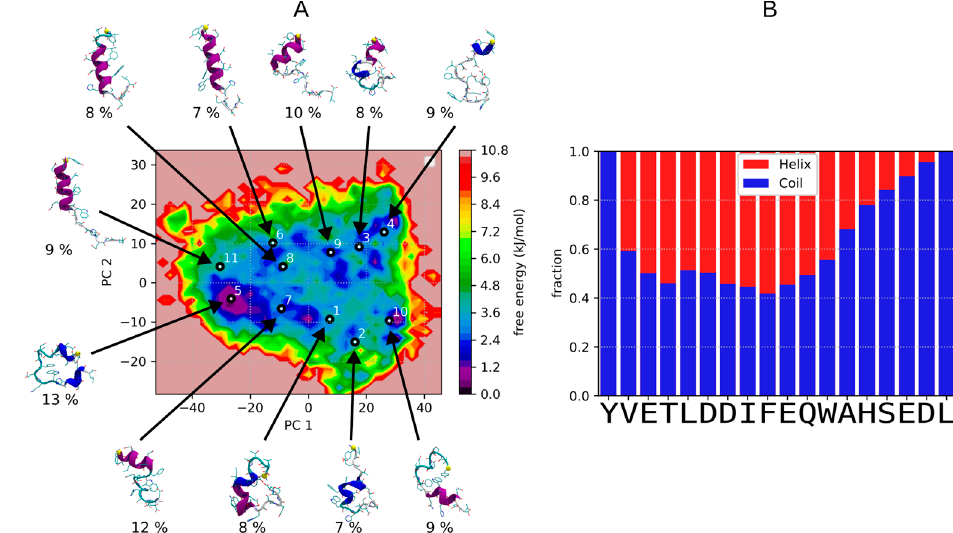
Figure 1. Structural landscape explored during ST simulations of C9h in aqueous solvent: ( A ) Free energy landscape at 300 K frames projected on principal component 1 (36% of variance) and 2 (10% of variance). Principal component analysis (PCA) applied to the 300 K frames ST simulation dataset of Caspase 9 peptide. Conformations representative of the clusters identified using k-means algorithm with k = 11 clusters (k has been chosen using the minimum silhouette score value for k values between 2 and 20) are depicted for each cluster together with the population of each cluster (%). ( B ) Analysis of the fraction of secondary structure adopted at each position of the peptide over all 300 K frames. Assignment of secondary structures was computed using DSSP [27].